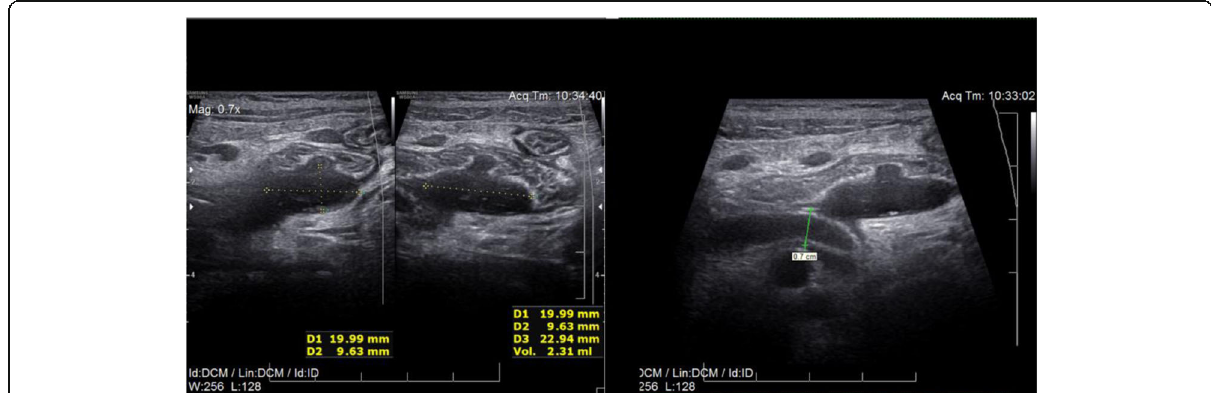
Fig. 1 Blind loop with AP diameter of 7 mm at lower quadrant right mucosal layer in in favor of perforation with adjacent fluid collection (2.3 cc) and disruption of the mucosa of the appendix